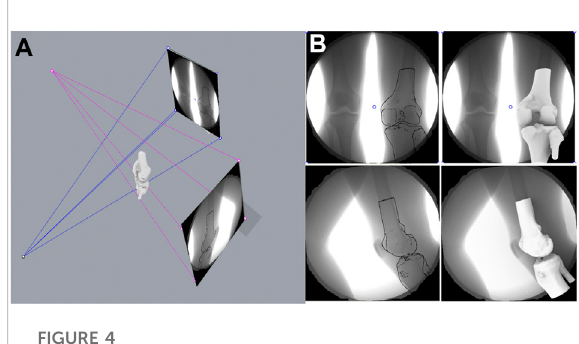
Kinematic measurement of six degrees of freedom of the knee joint. (A) Mechanism of the dual-plane fl uoroscopic imaging systemformeasuringkneekinematicindicators. (B) Registrationof 3-dimension model of knee joint with kinematic